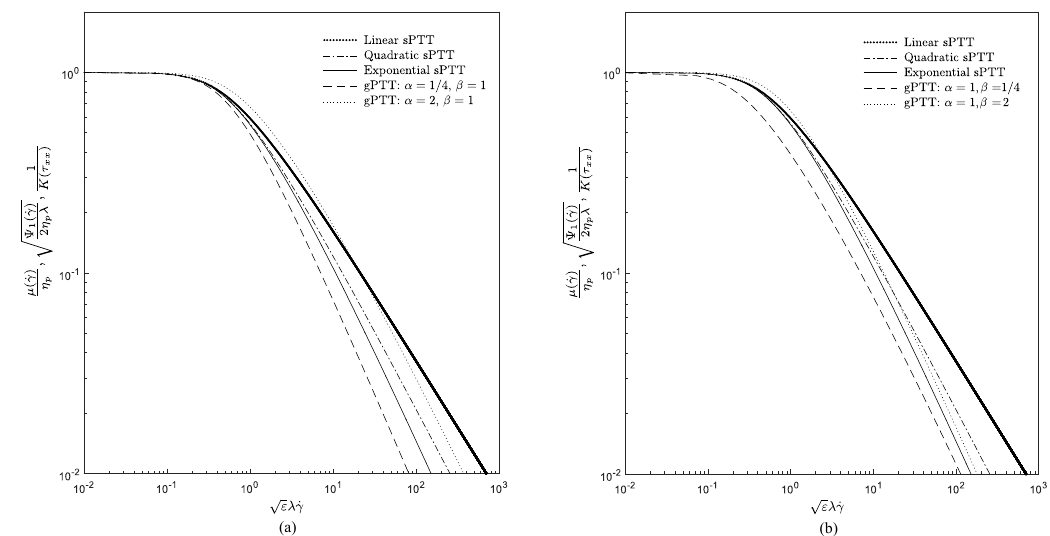
Figure 1. Dimensionless material properties in steady-state Couette flow using the three versions of the sPTT and for the gPTT model: ( a ) β = 1; and ( b ) α =